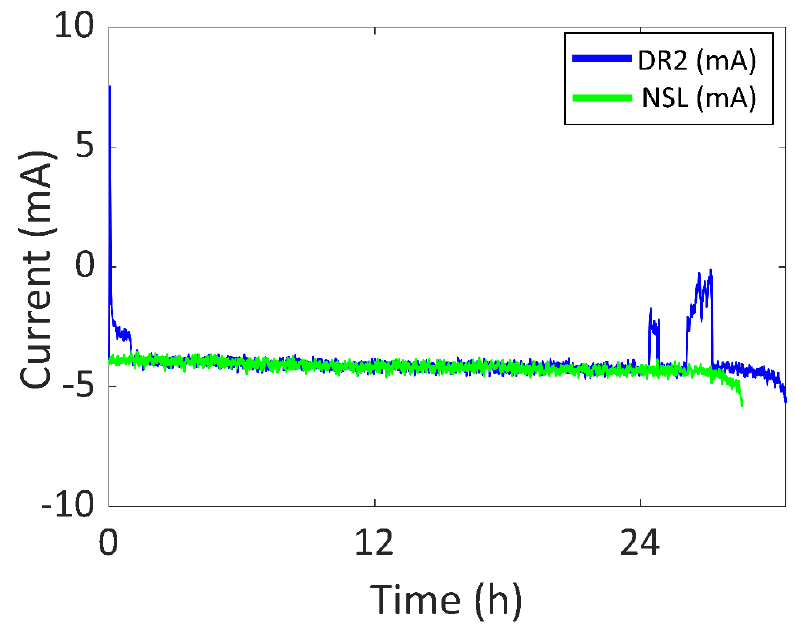
Figure 14. Battery current vs. time of DR2 and NSL experiments.